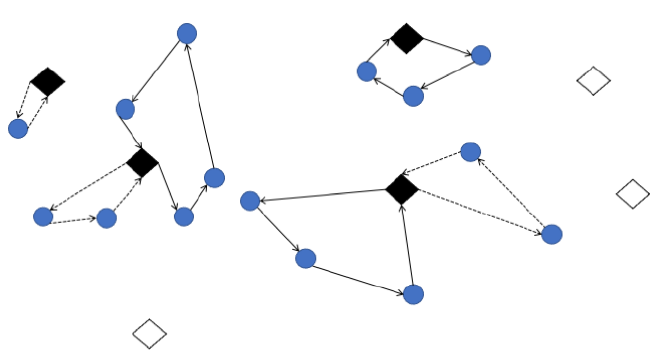
Figure 1. Graphical representation of a location routing problem (LRP)